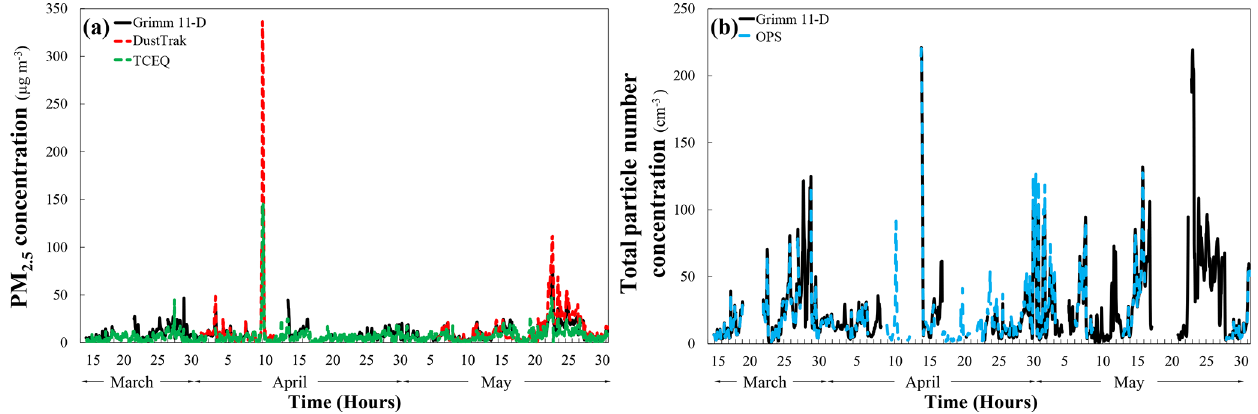
Figure 4. (a) Hourly values of PM 2 . 5 from the Grimm 11-D (black), DustTrak (red), and TCEQ station (green) and (b) total number concentrations from the Grimm 11-D (black) and OPS (light blue) as measured during March–May 2019.